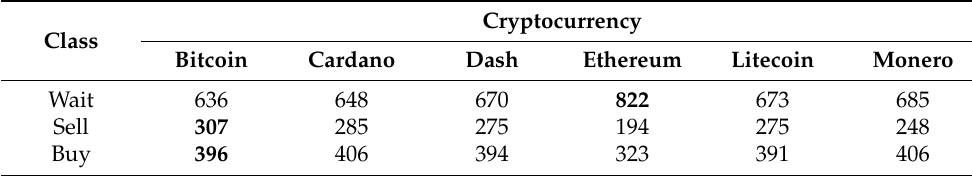
Table 9. Class distribution for each